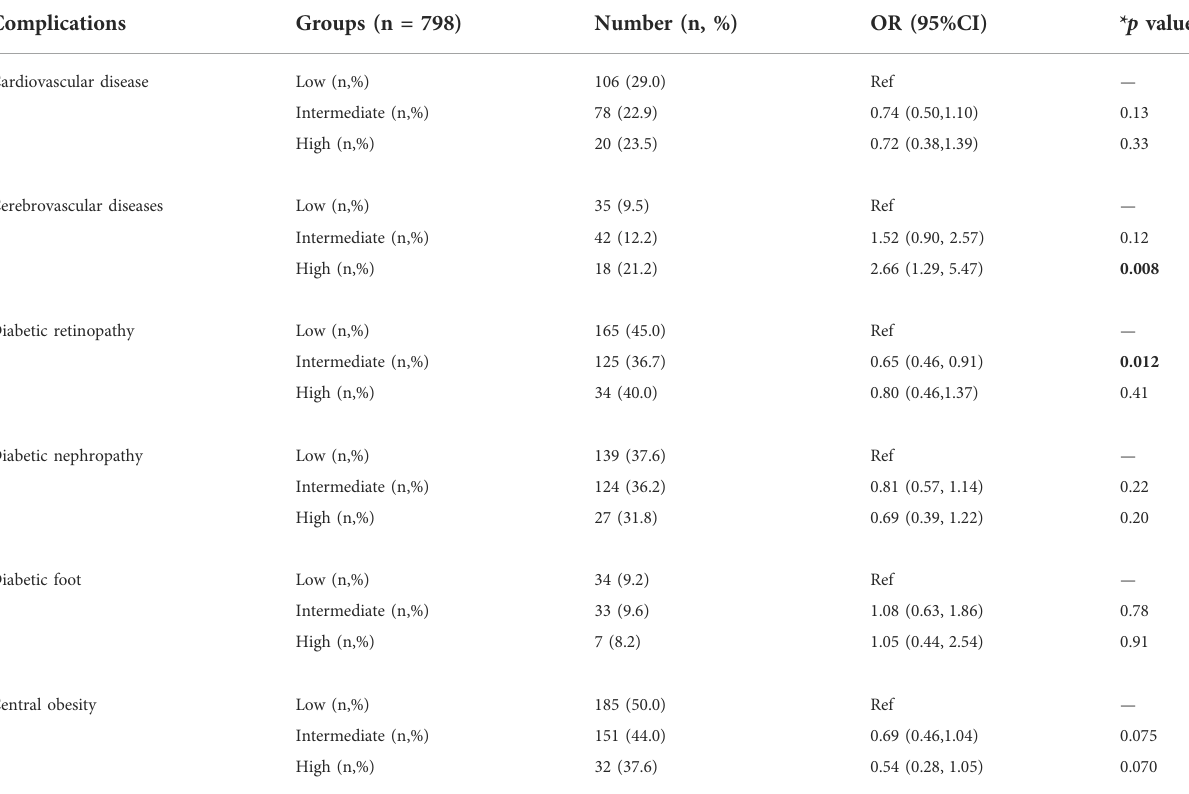
TABLE 2 Effect of the TRIB3 promoter 33 bp VNTR on common complications of T2DM.